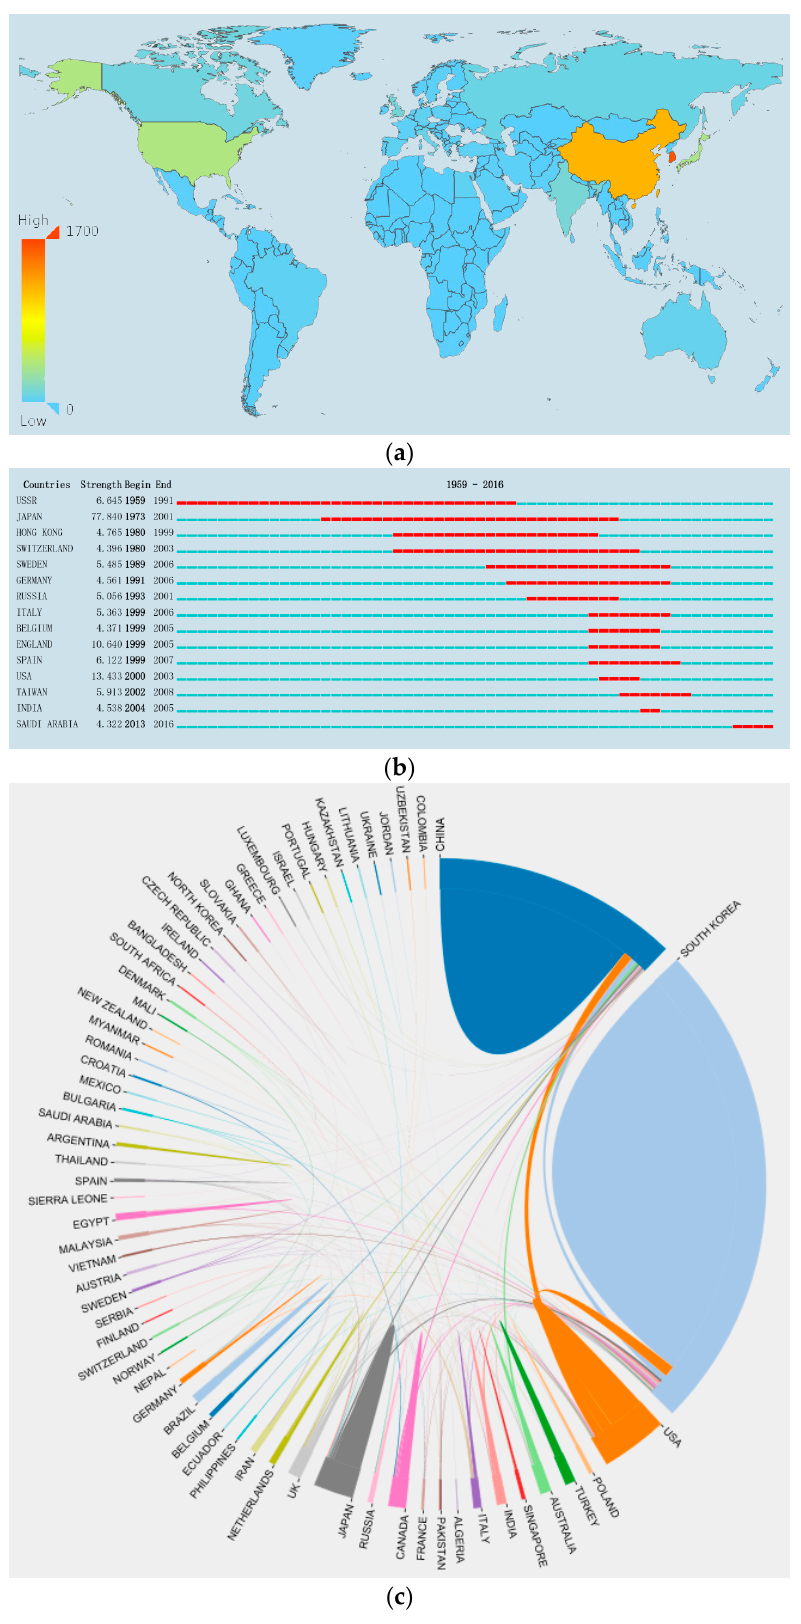
Figure 2. Global research status of Panax ginseng. ( a ) Geographical distribution of research countries; ( b ) 15 countries with burst detection among 64 countries; ( c ) Global cooperation.